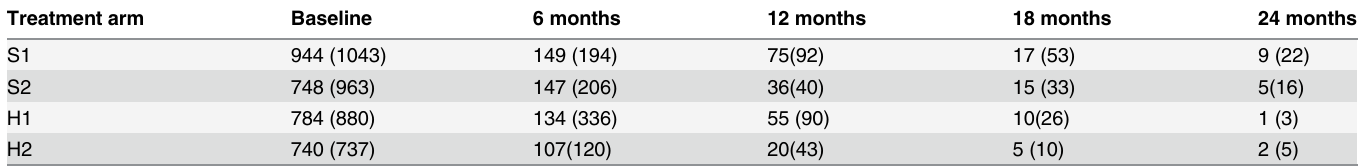
Table 4. Change in micro fi larial density in the treatment groups at different follow up points: Mean (SD) of Mf count/ml in blood for different treatment arms over 24 months. Treatment